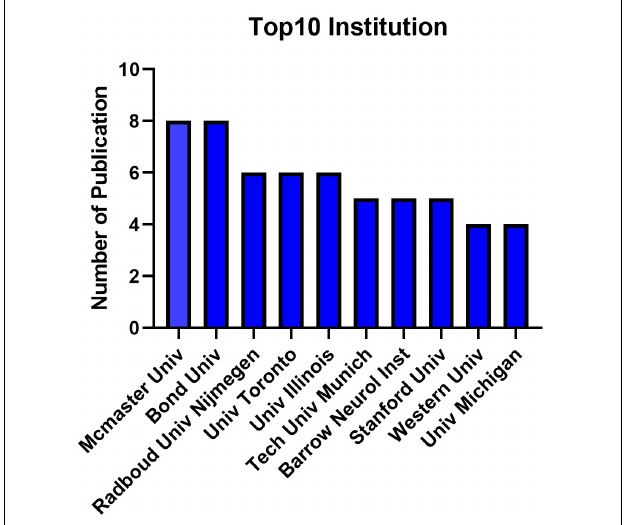
FIGURE 9 | The publication of top 10 authors.